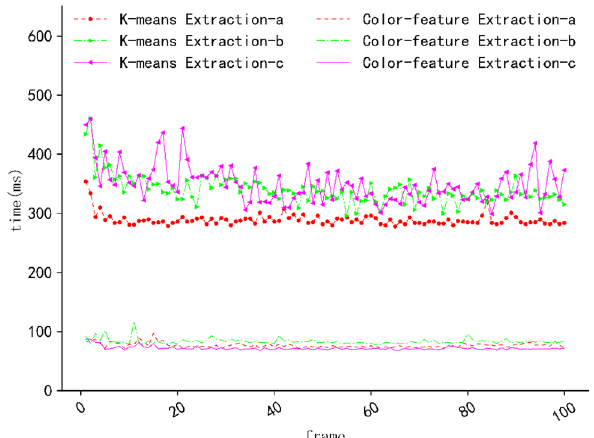
Fig. 10 Comparison of time-consuming acquisition of crop regions based on K-means and color features